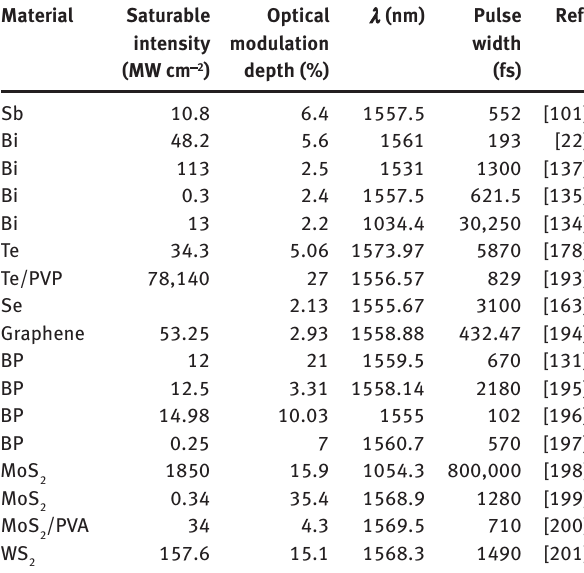
Table 3: The comparison of saturable absorber based on the state- of-the-art 2D materials.